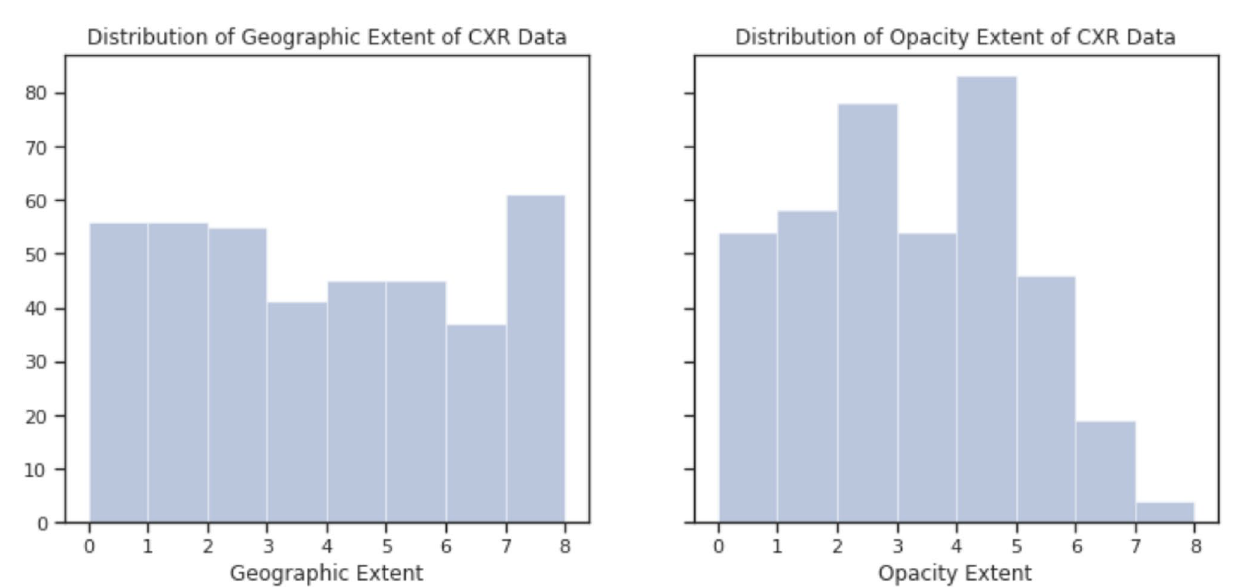
Figure 3. Distribution of geographic and opacity extent scores for patient cases used in this